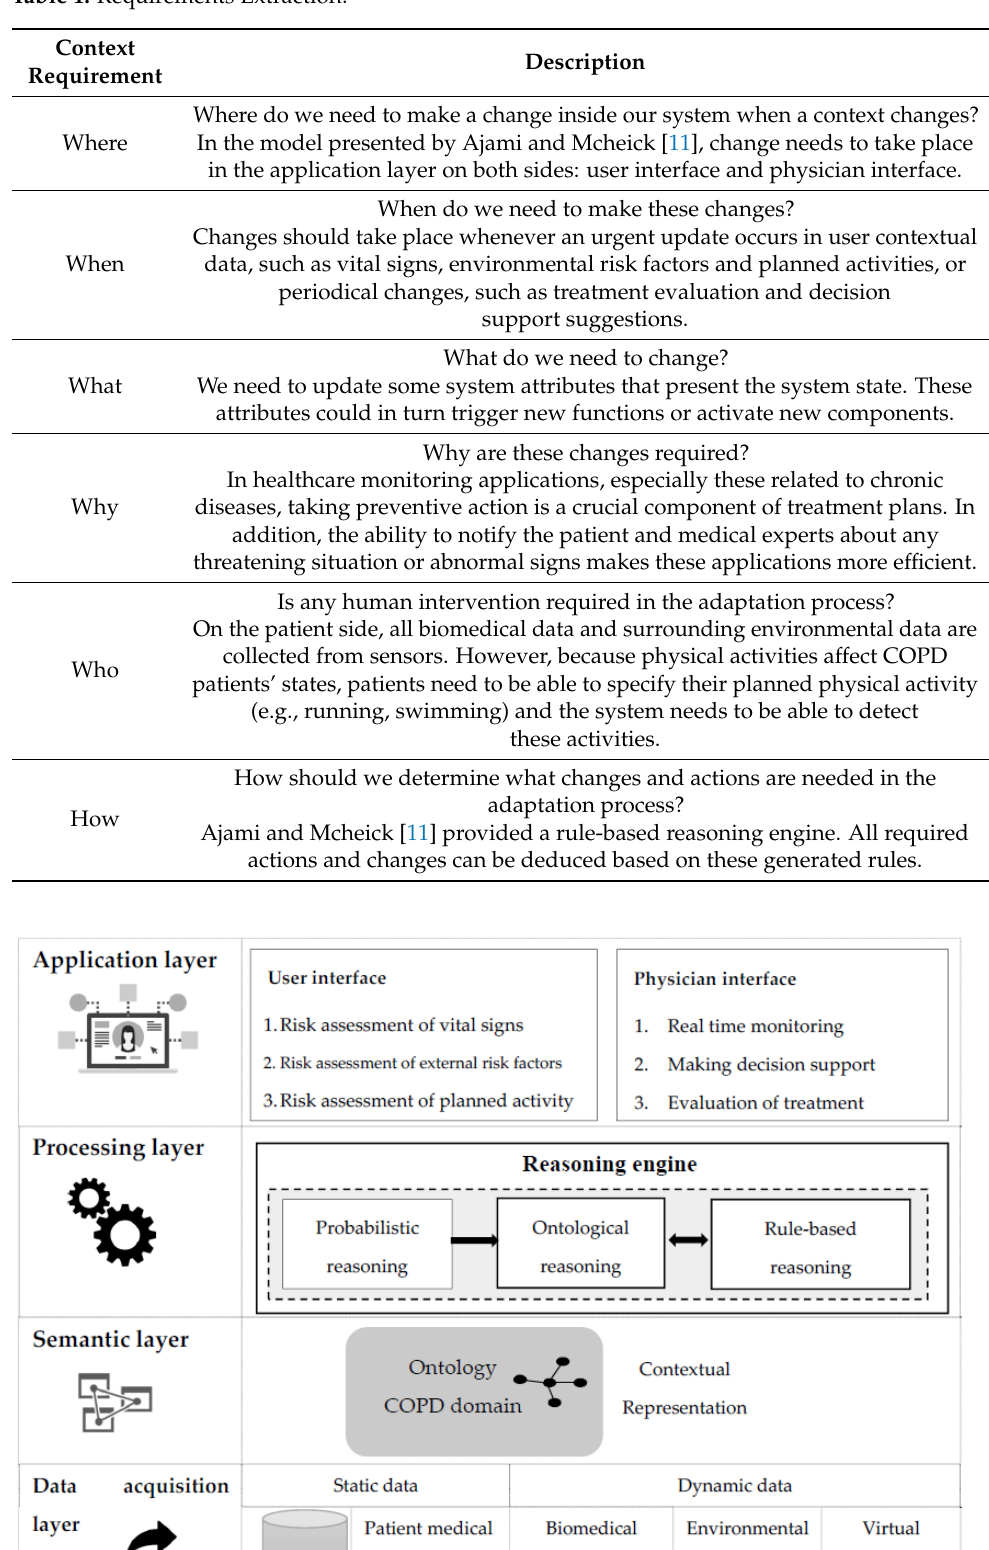
Table 1. Requirements Extraction.